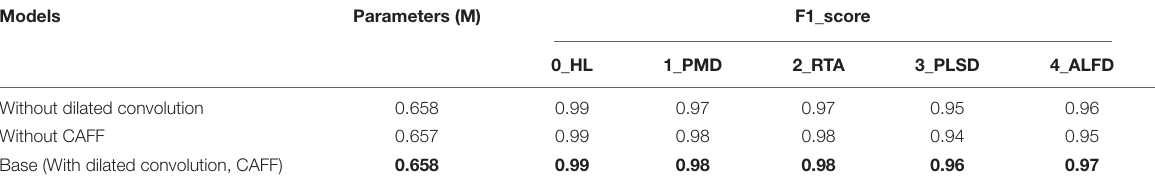
TABLE 6 | Effect of standard and dilated convolution.